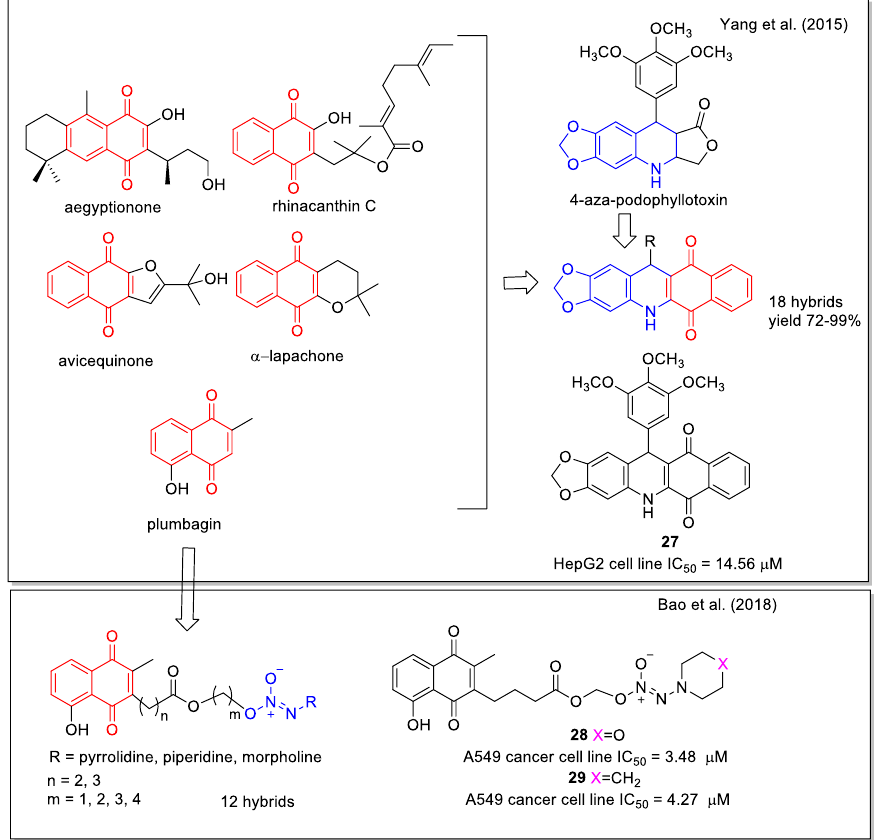
Figure 11. 1,4-Naphthoquinone hybrids with 4-aza-podophyllotoxin as reported by Yang et al. [42] and with diazeniumdiolate scaffold by Bao et al. [43].